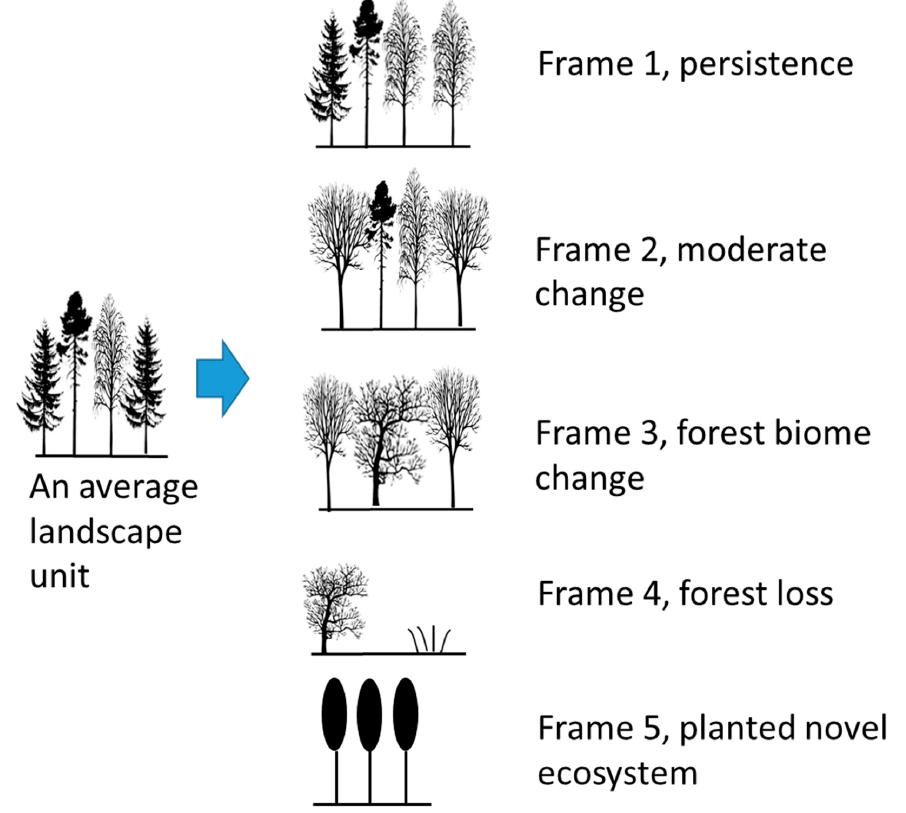
Figure 3. The frames of change in stand types and species composition—a trailing edge southern boreal forest example with leading temperate deciduous forest and oak savanna just to the south. Frame 1, persistence, the same tree species composition is sustained, perhaps with some minor shifts in relative abundance. Frame 2, moderate change, there are substantial changes in relative abundance of dominant tree species. Frame 3, forest biome change, major turnover of species composition, e.g., transition from boreal to temperate species. Frame 4, forest loss, change from forest to non-forest biome (e.g., savanna or grassland). Frame 5, novel ecosystems are established using exotic tree species suited to the new climate.